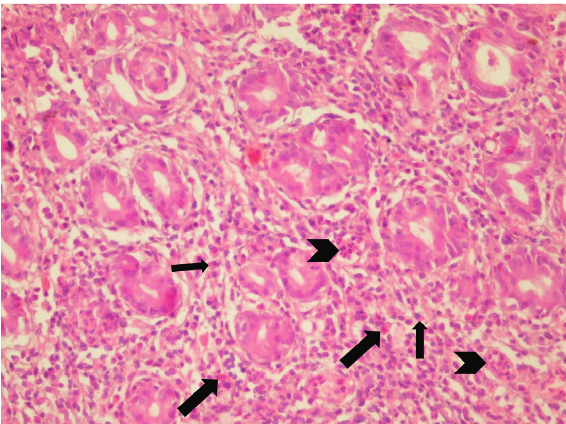
Figure 5: Photomicrograph showing chronic active gastritis with large number of neutrophils (arrow heads) and mixed inflam- matory cell infiltrate, namely, plasma cells (thin arrow), lympho- cytes (arrow heads), and eosinophils (thick arrow), with moderate atrophy, H&E stain, × 200.